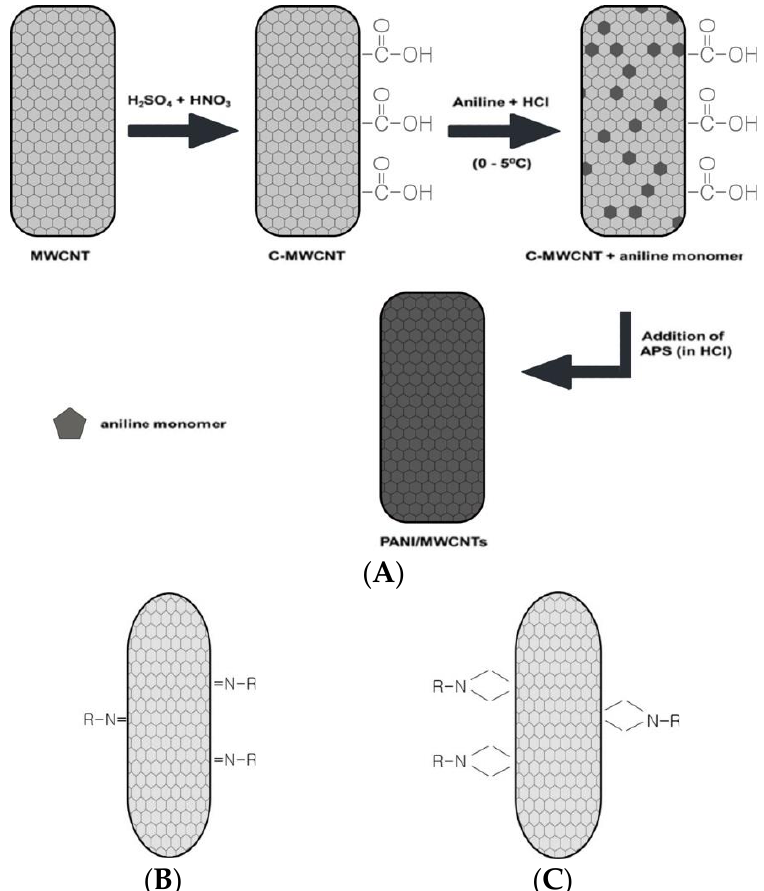
Figure 2. The scheme of functionalized CNTs. ( A ) The chemical process for forming covalent bond on the CNTs through oxidation process [53]; ( B ) The chemical process for forming covalent bond on the CNTs through a photochemical oxidation process; ( C ) The chemical process for forming covalent bond on the CNTs through an electrochemical oxidation process [57].